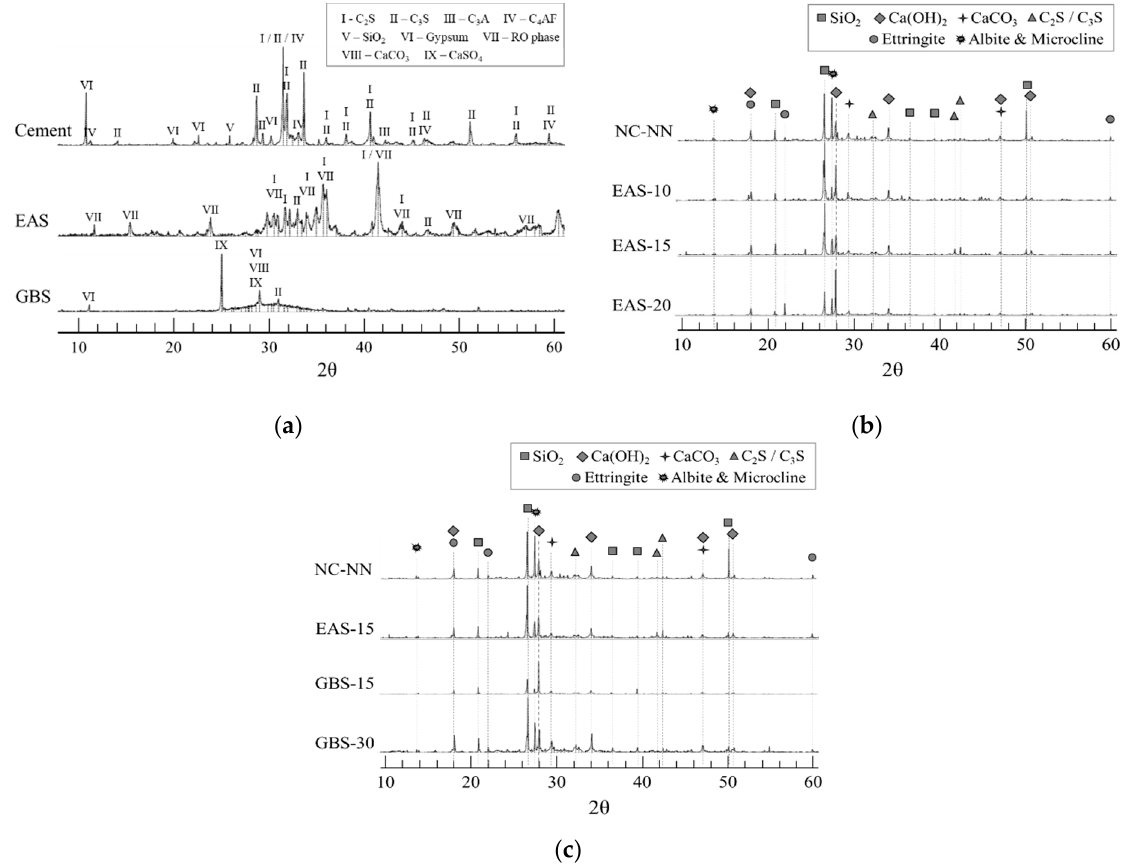
Figure 2. XRD analytical results: ( a ) comparison of cementitious materials; ( b ) comparison of EAS replacement ratio; ( c ) comparison of EAS and GBS.